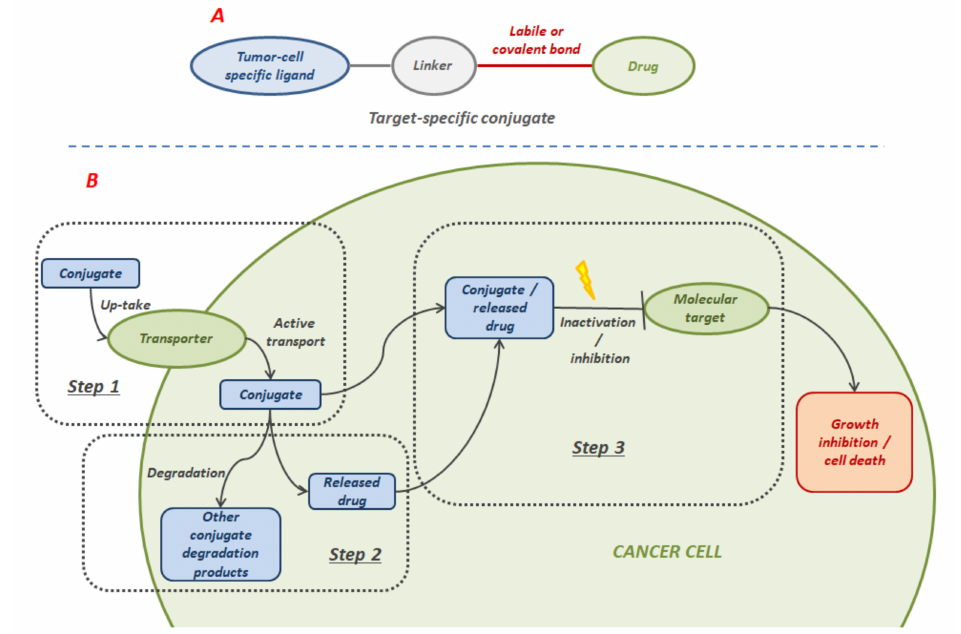
Figure 11. The general structure of tumor-specific conjugates ( A ) and their putative mechanism of uptake and action ( B ).